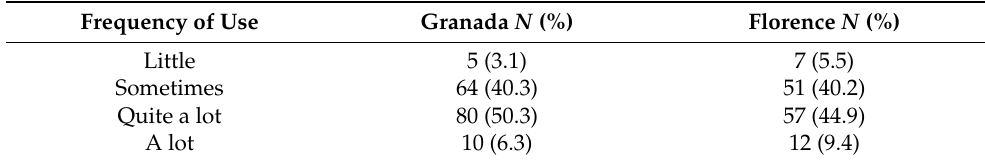
Table 2. Frequency of use of apps in Granada and Florence ( N =